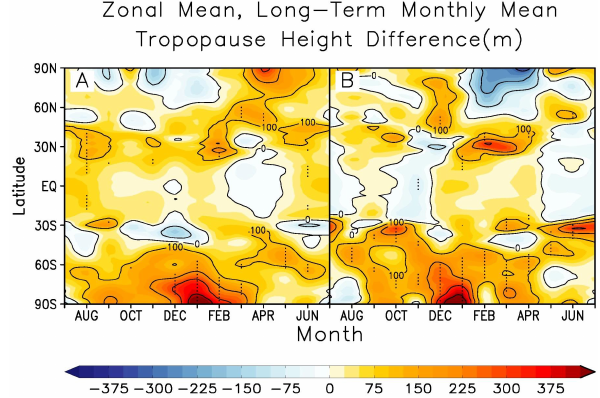
Figure 5: Long-term, monthly and zonal mean WMO (lapse rate) tropopause height differences (m) for experiment pairs A (left) and B (right). Positive differences are shown in warm colours and negative in cold colours. See Figure 2 for definition of the differences. Differences that exceed one standard deviation of the ‘Control’ are stippled.